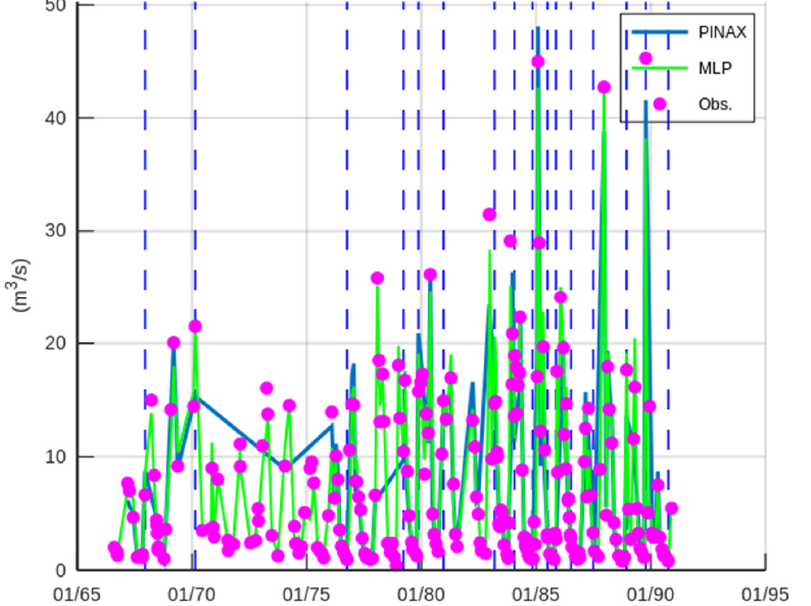
Figure 11. Agrafiotis case study—discharge calculated with the MLP and discharge calculated with the 16 PINAX-obtained regressions. The start and end of these 16 periods are marked with the dashed vertical lines.